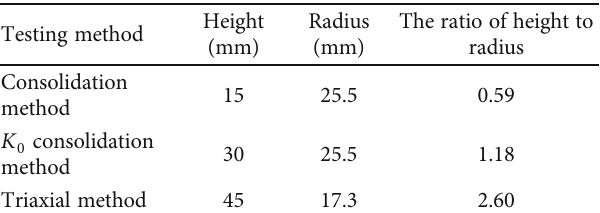
Figure 3: Side expansion test of a fl at shovel. Table 2: Sample